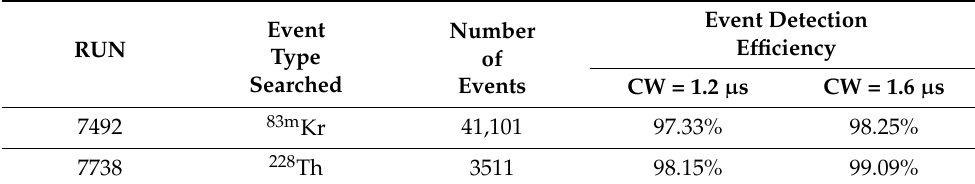
Table 4. Coincidence Event Processor efficiency results. Configuration under study: Two mini- mum PMT hits in a Coincidence Window (CW) of 1.2 µ s (run parameter) and 1.6 µ s (maximum possible